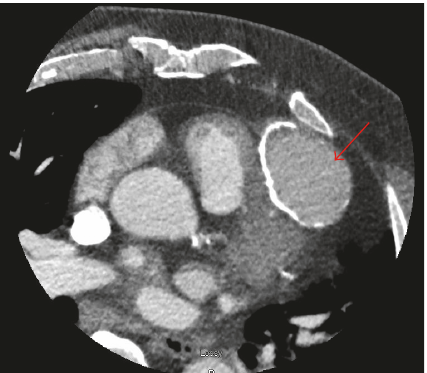
Figure 6: Cardiac CTA. Pseudoaneurysm arising superiorly from the mid-apical free wall of the right ventricle measuring up to 6.1cm in maximal diameter with a 15mm neck (red arrow).